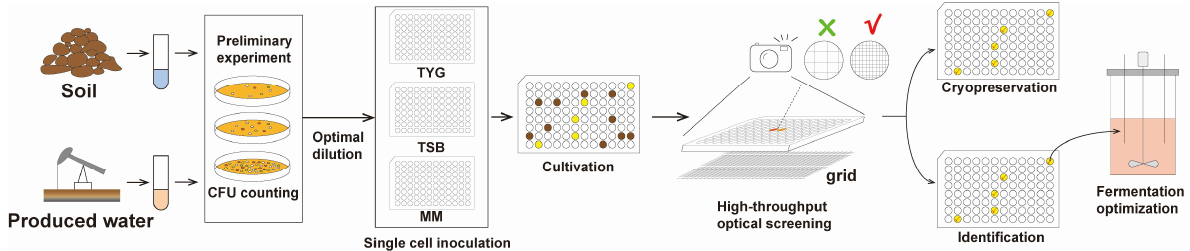
Figure 1. Schematic workflow of high-throughput single-cell-based cultivation and functional characterization of biosurfactant-producing bacteria.